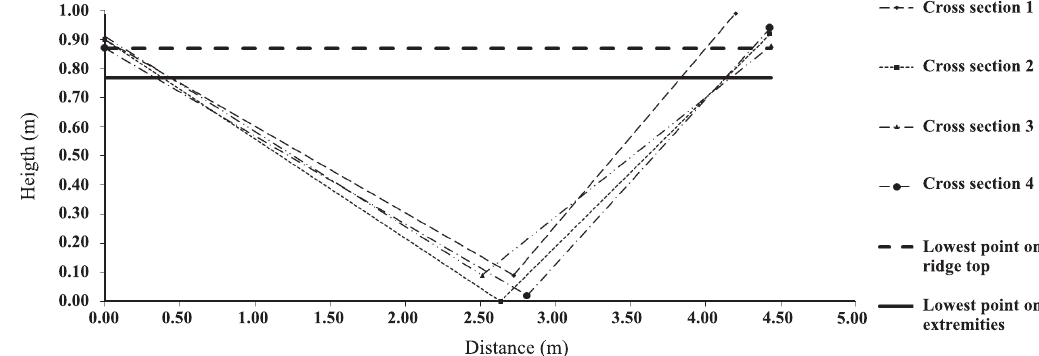
figure 5. cross section profile of the channel of terrace 1 after simulation of ridge height